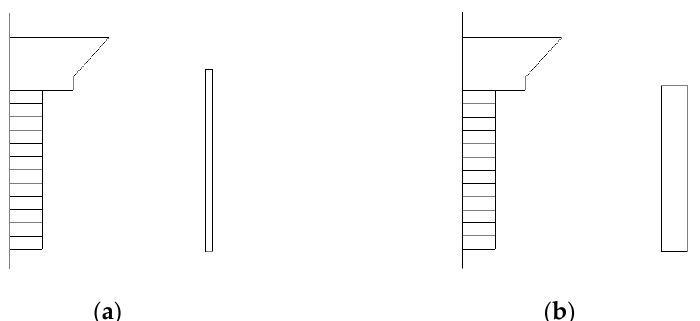
Figure 5. ( a ) The size of the aluminum ring before optimization. ( b ) The size of the aluminum ring after optimization.